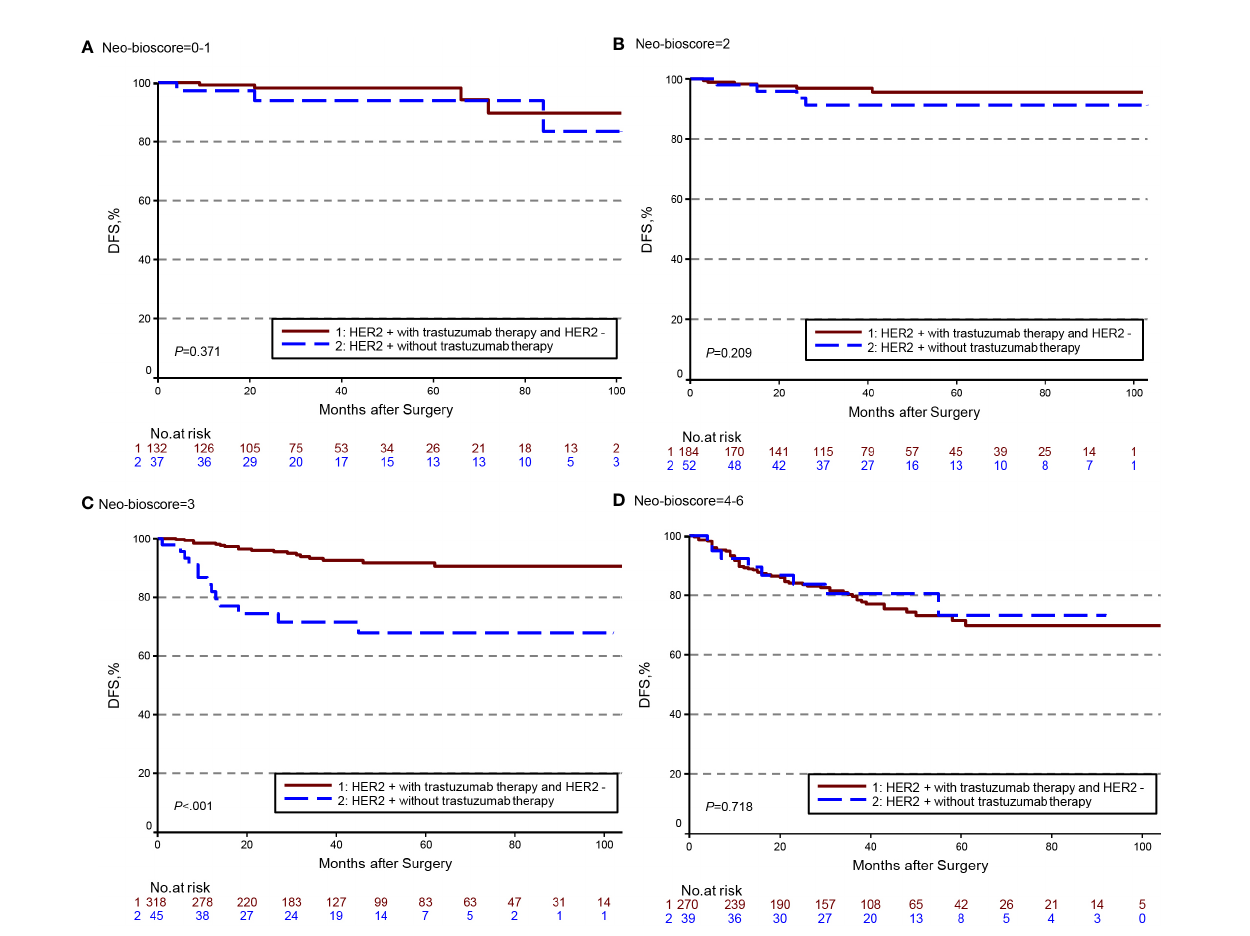
FIGURE 5 | Kaplan – Meier survival curves for disease free survival (DFS) determined by the Neo-Bioscore staging system for different HER2 status subgroup. Group 1: HER2-positive patients with trastuzumab therapy and HER2-negative patients; Group 2: HER2-positive patients without trastuzumab therapy. (A) DFS of different HER2 status subgroup in Neo-Bioscore scores 0 and 1; (B) DFS of different HER2 status subgroup in Neo-Bioscore score 2; (C) DFS of different HER2 status subgroup in Neo-Bioscore score 3; (D) DFS of different HER2 status subgroup in Neo-Bioscore scores 4, 5, and